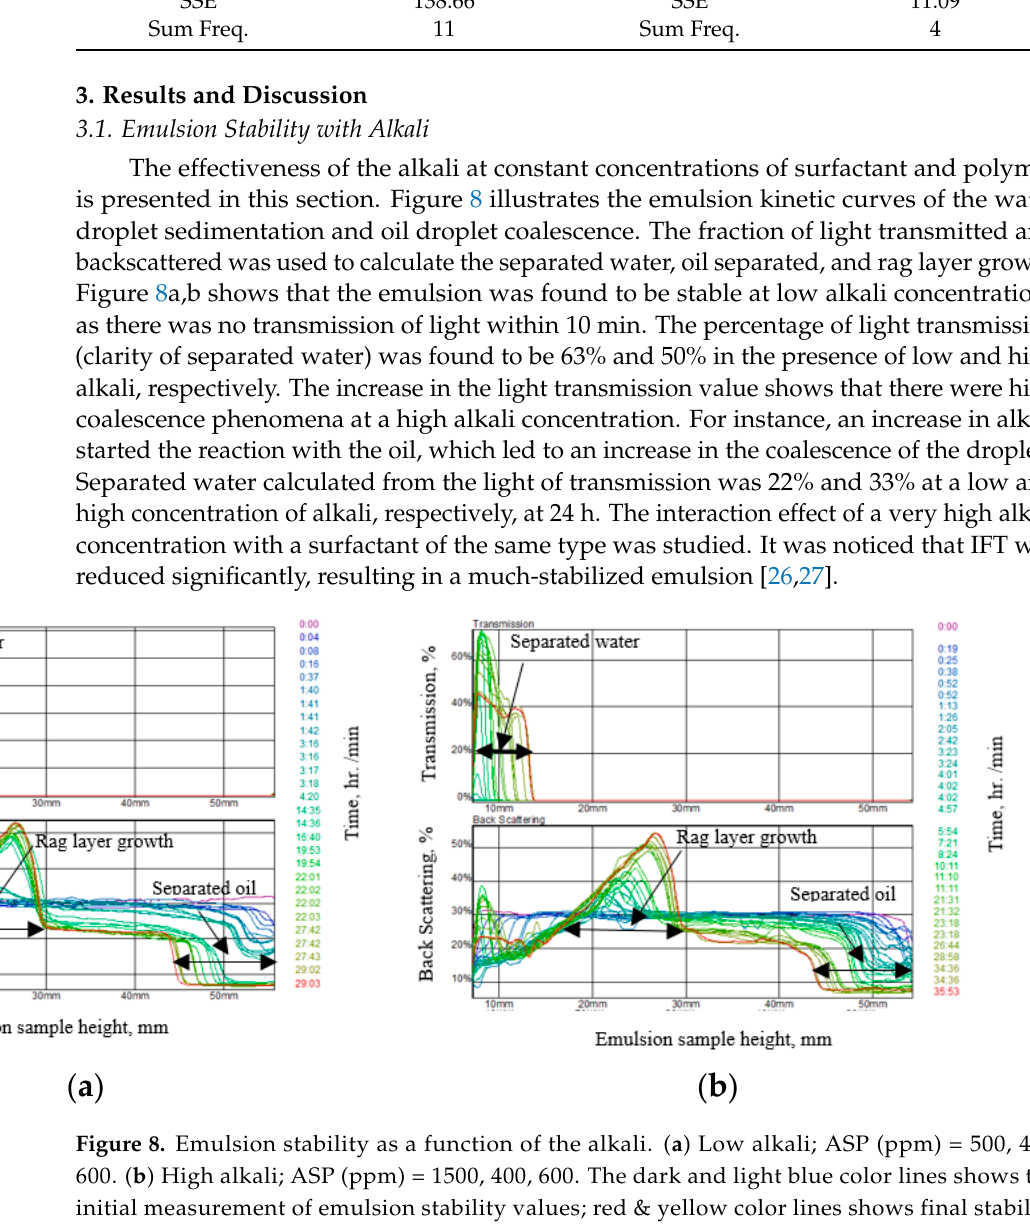
( b ) Figure 9. Emulsion as a function of the surfactant. ( a ) Low surfactant; ASP (ppm) = 1000, 200, 600. ( b ) High surfactant; ASP (ppm) = 1000, 600, 600. The dark and light blue color lines shows the initial measurement of emulsion stability values; red & yellow color lines shows fi nal stability measure- ment values.